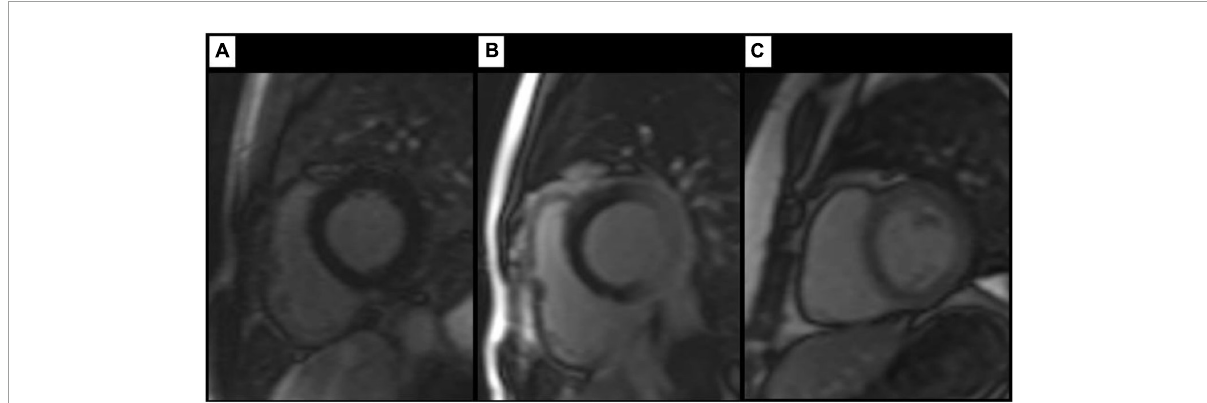
FIGURE1 Findings on TI scout images. Artefact-free TI scout (A) in a healthy control. Images (B,C) show different degrees of inhomogeneous myocardial nulling in patients with LBBB, resulting in a pronounced, C-shaped nulling of the septal and anterior wall segments. Review of supplemental sequences revealed no morphologic correlate in any of the cases shown.